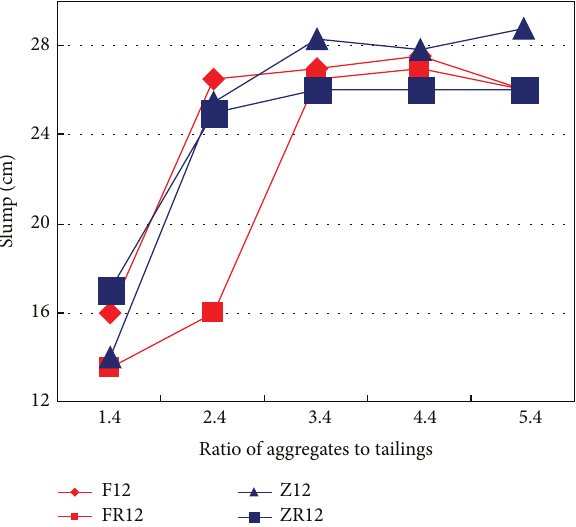
Figure 6: 28-day backfill UCS using 12% cement replacement.